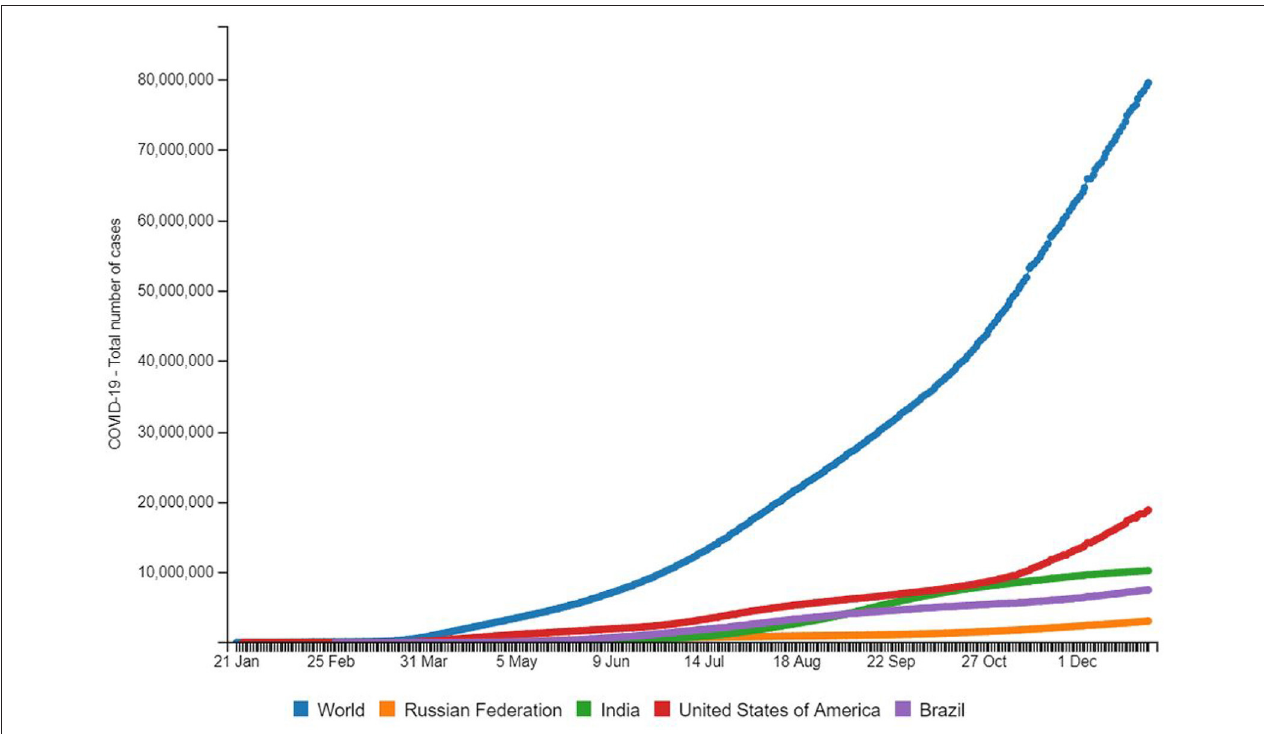
FIGURE 1 | Source: http://www.smaartrapidtracker.org, accessed on December 29, 2020. Total number of cumulative cases of COVID-19 in the world, Russia, United States of America, Brazil, and India (January 21, 2020 to December 29,